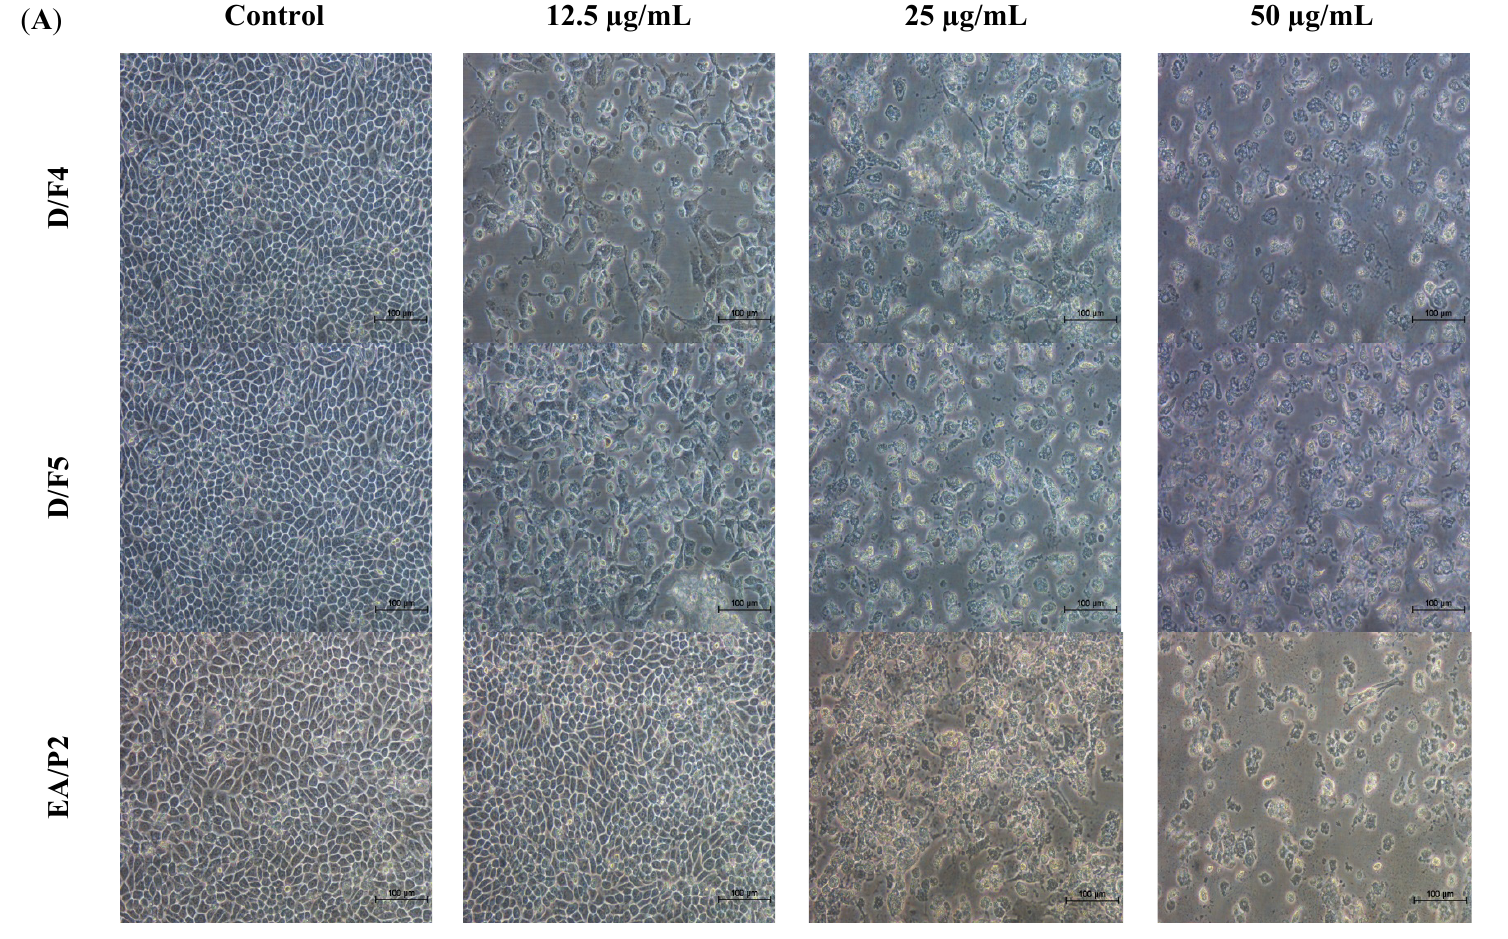
Figure 1. Morphological changes of ( A ) MCF-7 and ( B ) MDA-MB-231 cells treated with different concentrations of active fraction of D/F4, D/F5 and EA/P2 of D. suffruticosa for 72 h viewed under an inverted light microscope (200× magnification). Reduce in cell population was noted with the increase in the concentration of the treatment as compared to the control (untreated